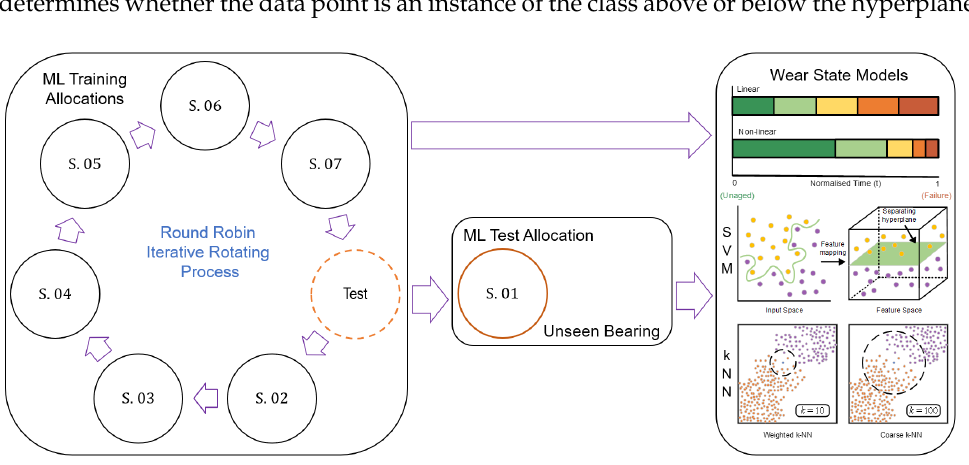
Figure 6. Experimental procedure for selecting the training and testing signals for the different ML